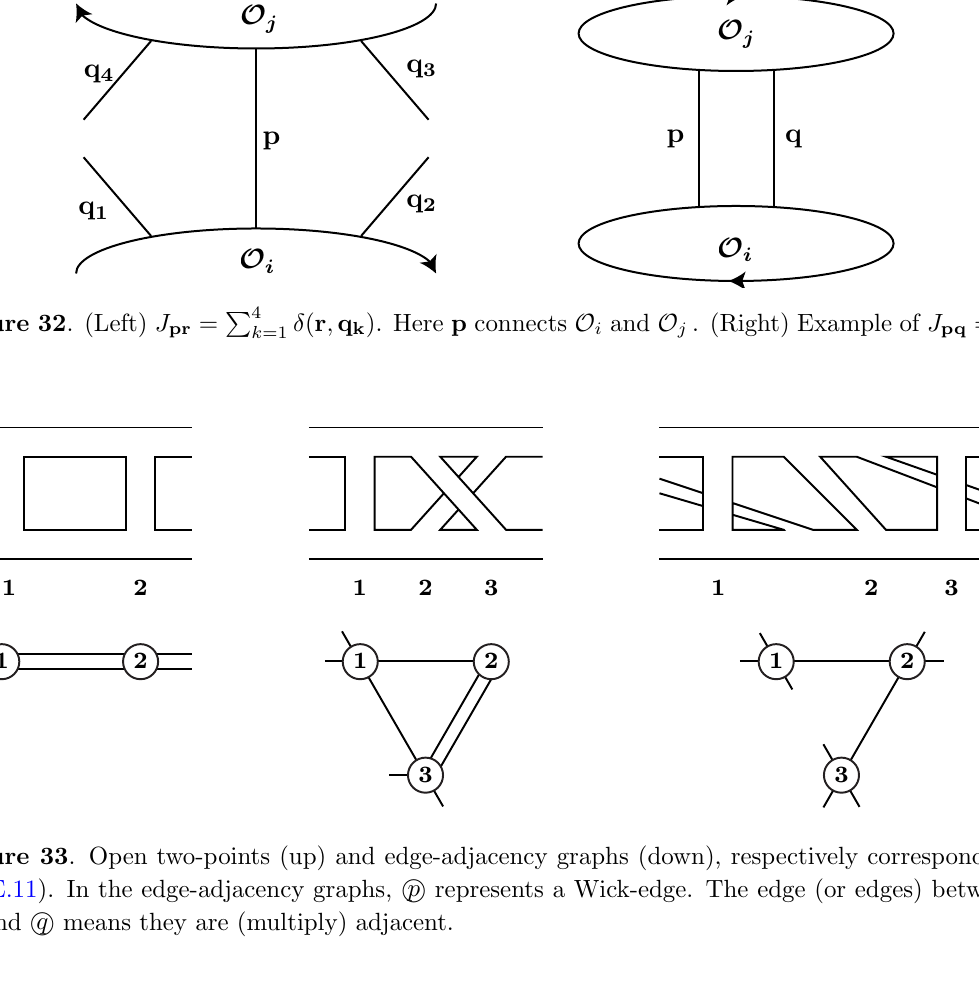
Figure 32 . (Left) J pr = P 4